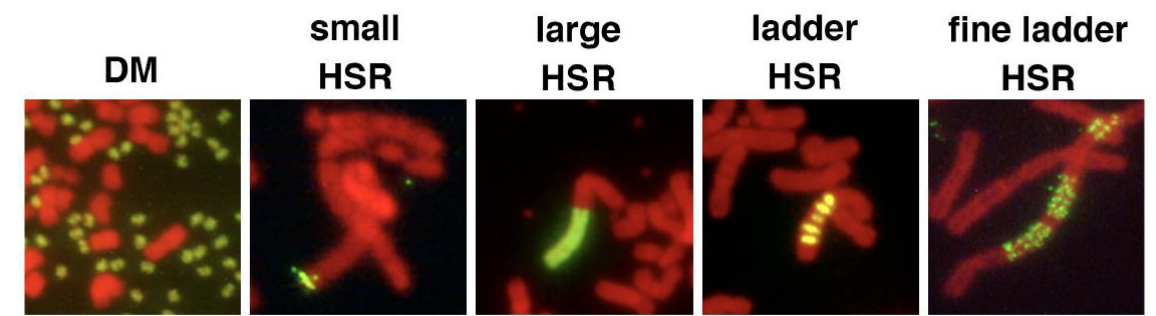
Figure 2. Amplification of IR/MAR-bearing circular plasmid in the transfected cells. An IR/MAR plasmid was transfected to human colorectal carcinoma COLO 320DM cells. Stable transformants were selected by drug for more than one month. The chromosome spread was hybridized with a probe prepared from the transfected plasmid. The hybridized probe was detected by green fluorescence, and the DNA was counterstained with propidium iodide (shown in red). The plasmid generated extrachromosomal double minutes (DM) or several types of homogeneously staining region (HSR). The photos of DM [43] and large HSR [38] appeared previously, and the other photos are unpublished.